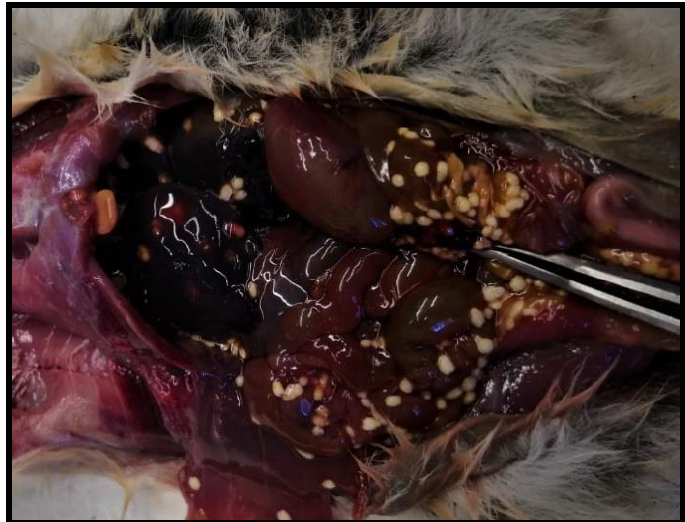
Figure 5. Parasite cysts in peritoneal cavity and on liver.